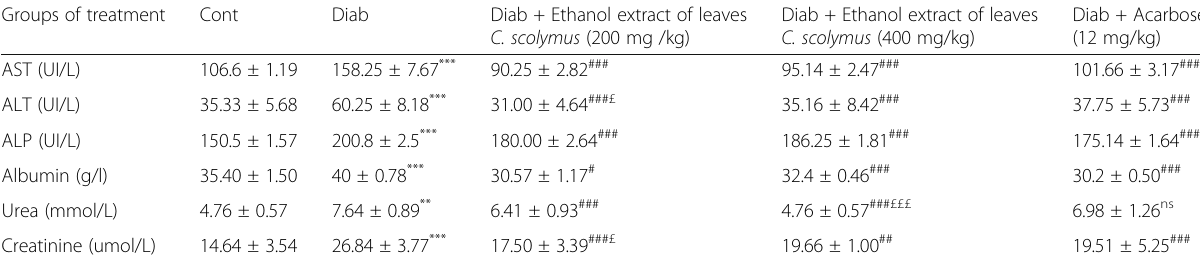
Table 9 Effect of Cynara scolymus leaves extracts on liver-kidney dysfunction of experimental groups of rats Groups of treatment